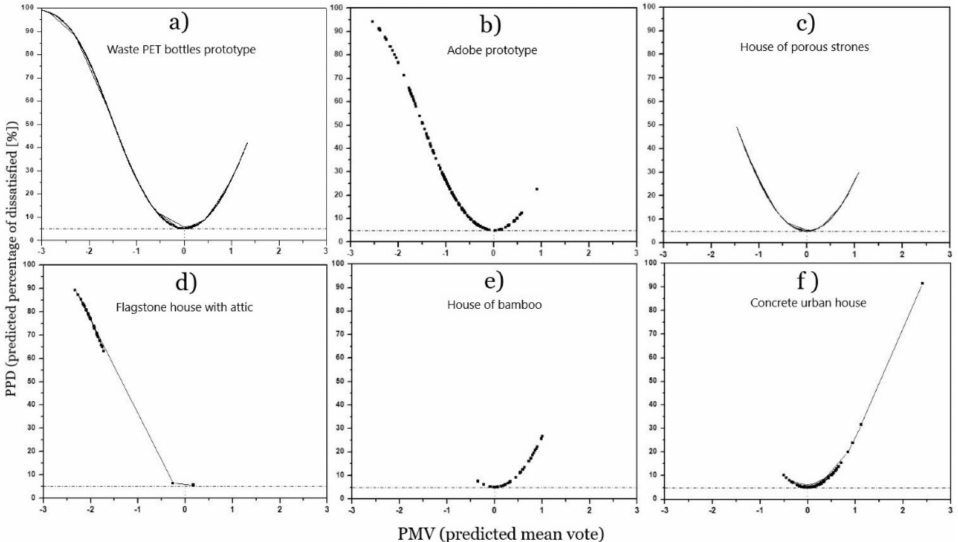
Figure 8. Graphs of the indices of Estimated Average Vote (PMV-predicted mean vote) and PPD- predicted percentage dissatisfied of the studied